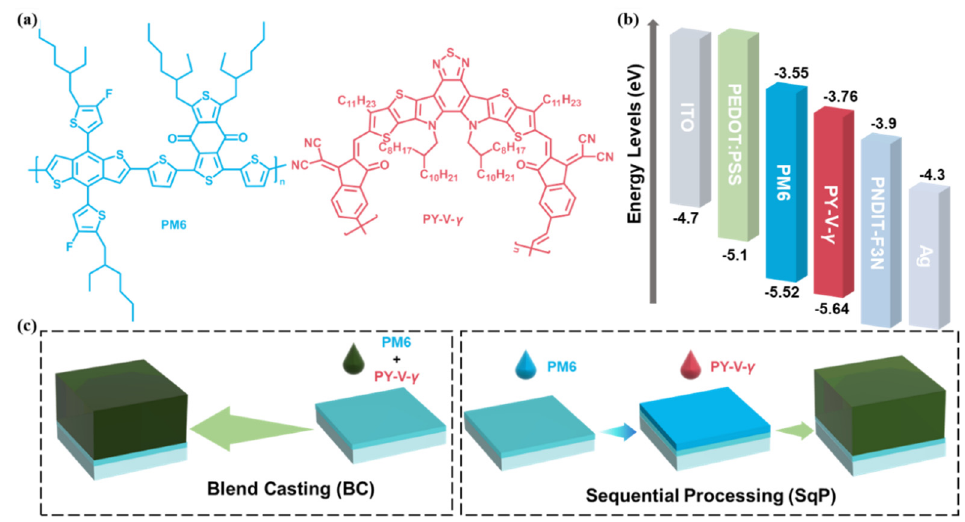
Figure 1. ( a ) Chemical structures of PM6 and PY-V- γ . ( b ) Energy level diagram. The bottom and top of the bar represent HOMO and LUMO, respectively. ( c ) Schematic diagram of blend-casting and sequential processing.